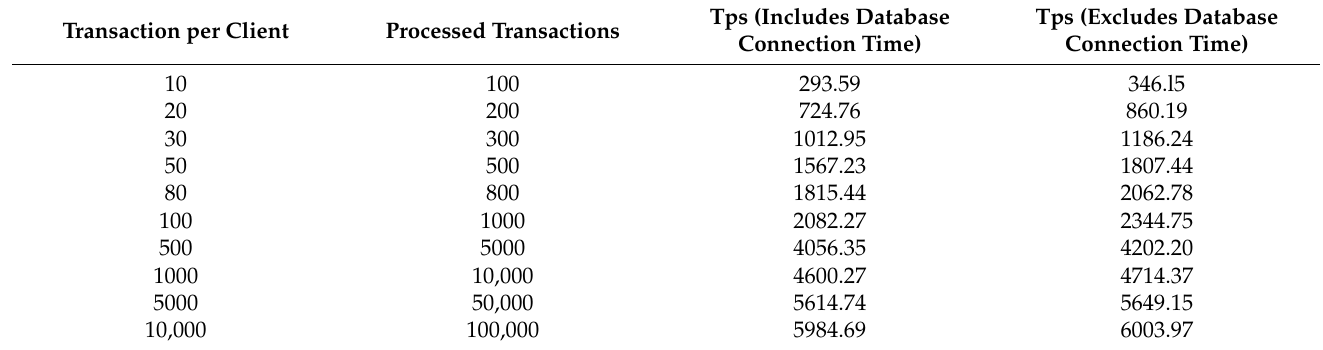
Table 1. Testing the database and analyzing its performance in relation to the number of